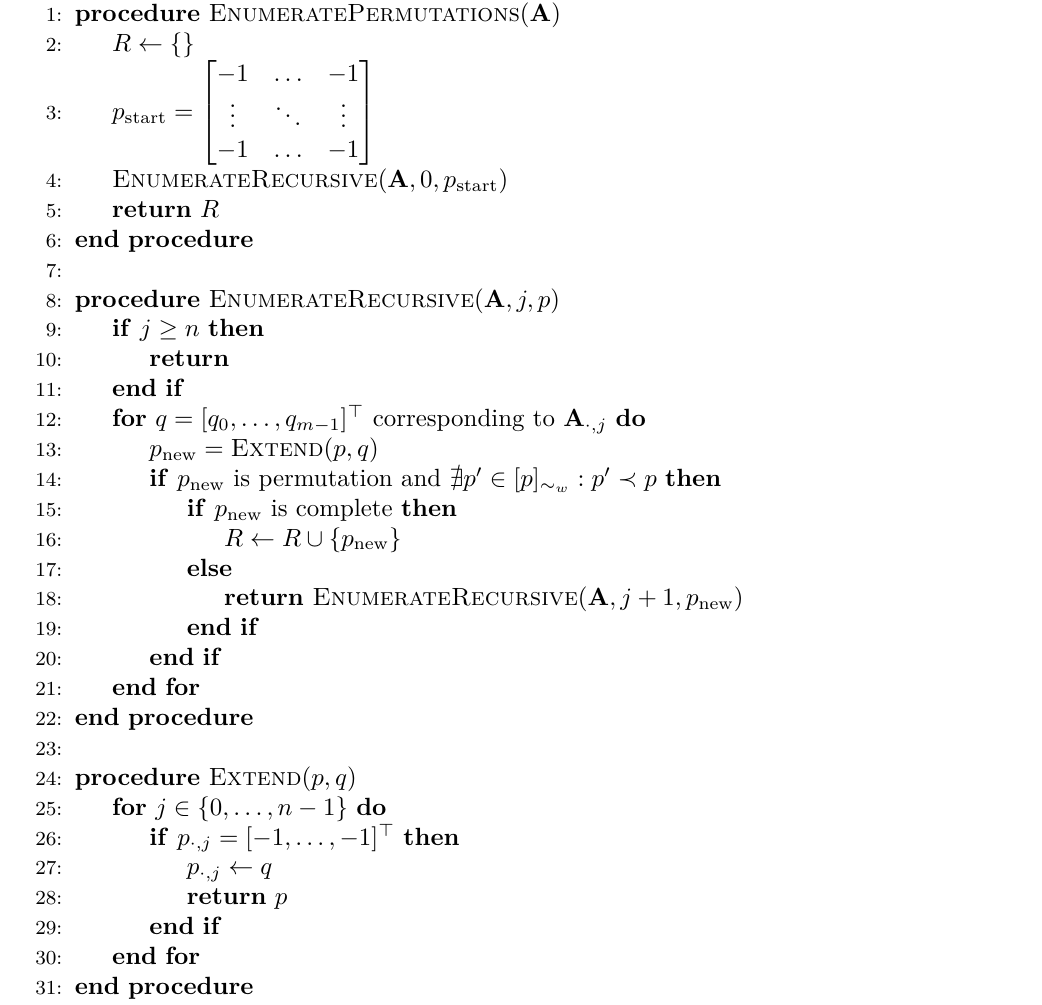
Algorithm 1 Enumerate all permutations upto weak M -equivalence for a given structure matrix